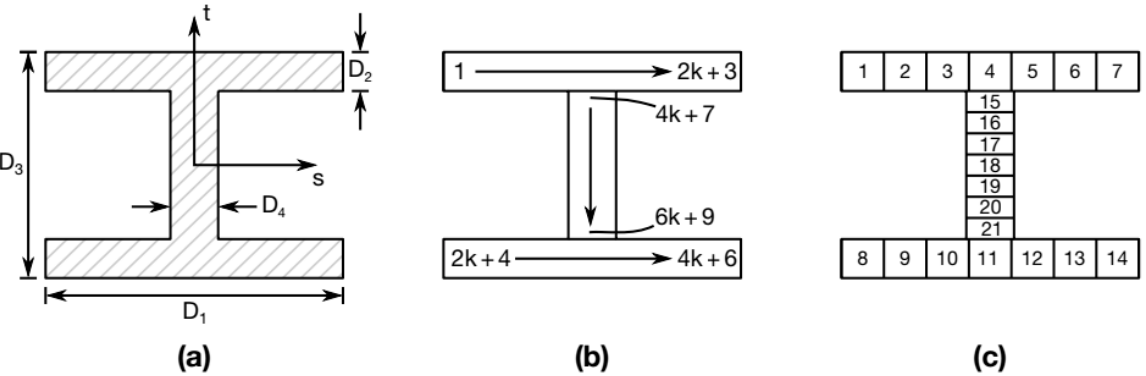
Figure 2. FE numerical modelling of H-section steel column with Hughes–Liu beam elements: ( a ) cross section geometry; ( b ) integration point numbering; ( c ) section example for k = 2.